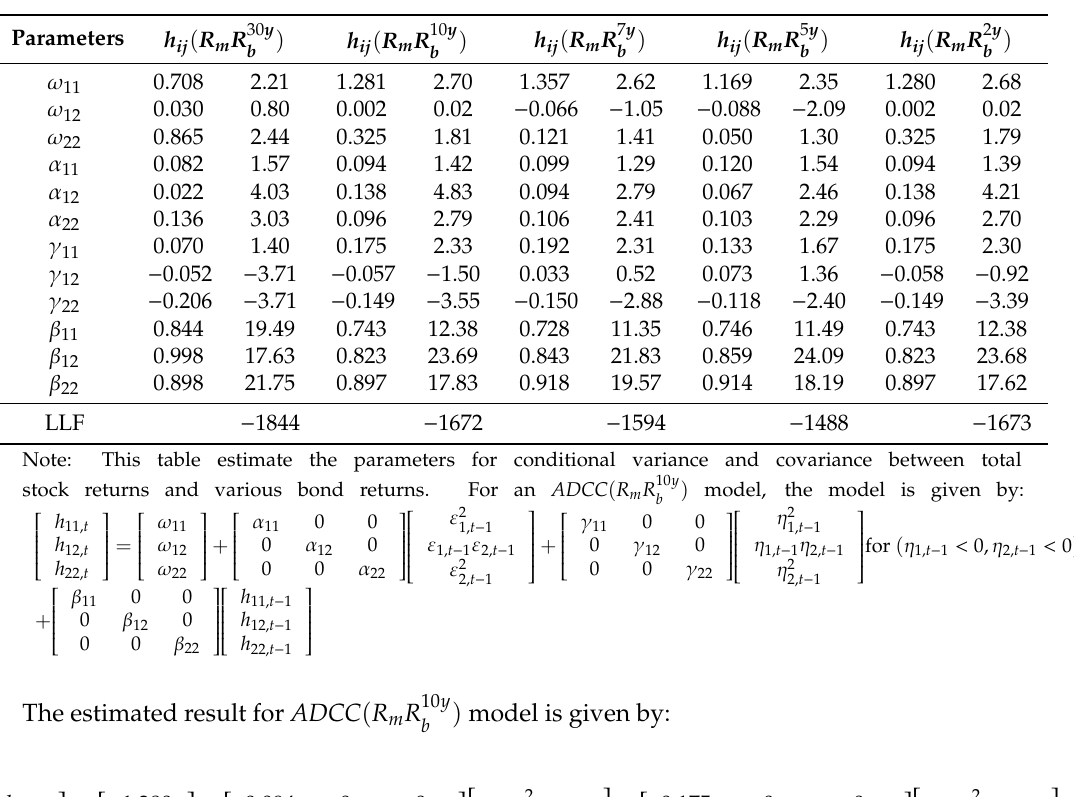
Table 2. Estimates of the asymmetric dynamic correlation (ADCC) models parameters for stock–bond return